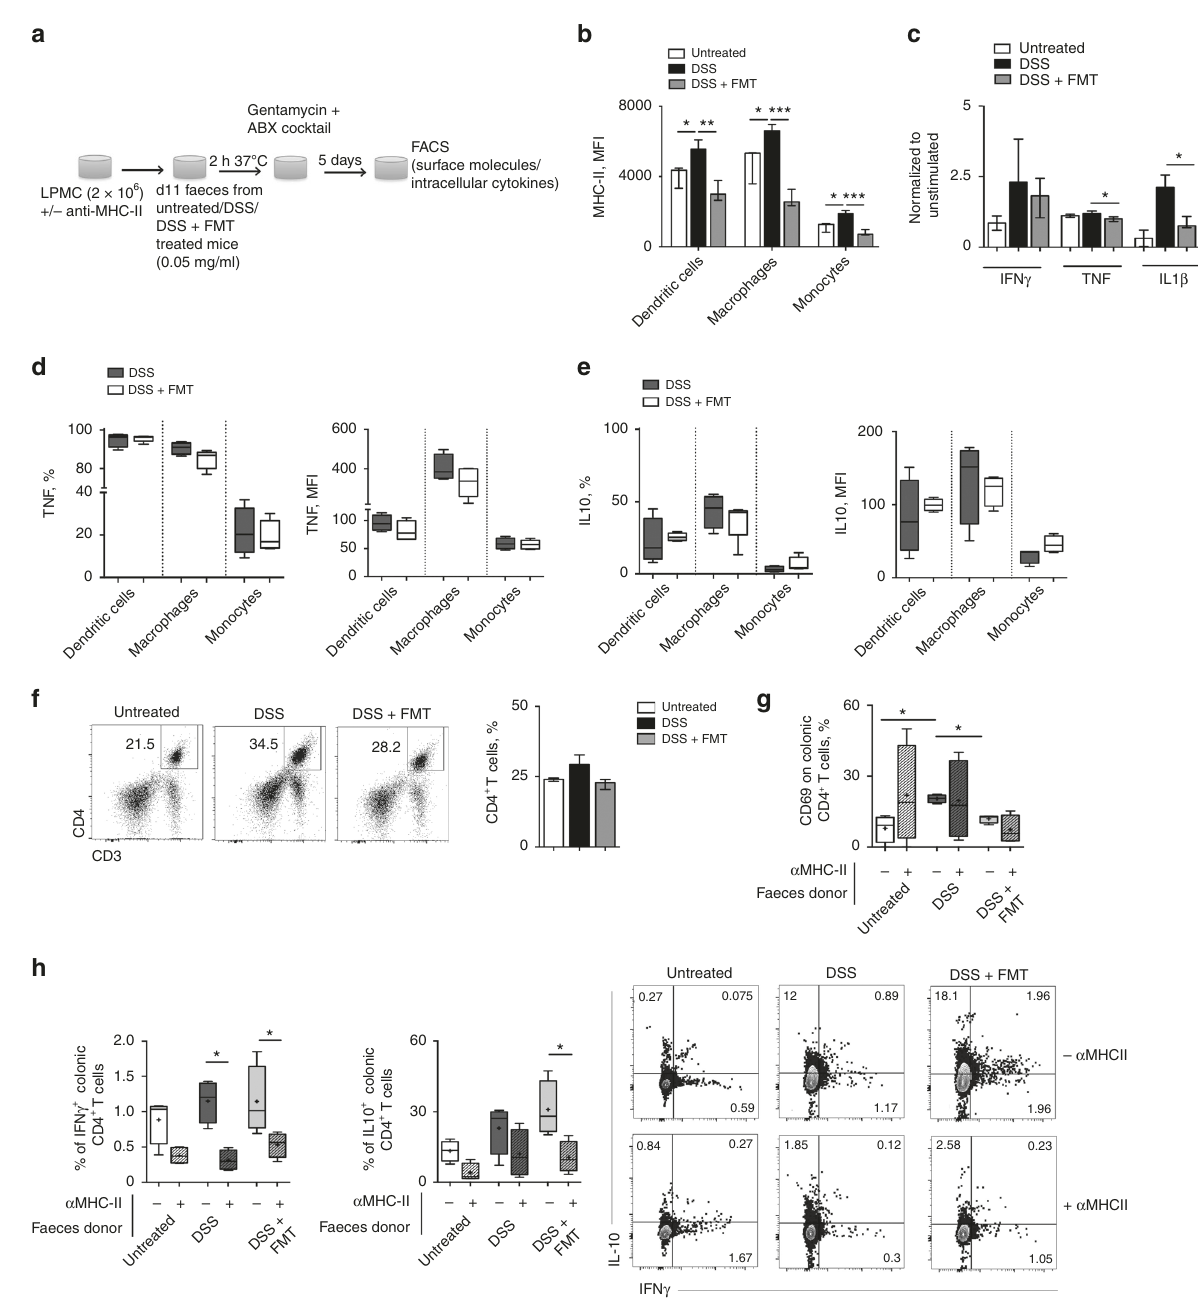
Fig. 6 Bacterial antigens presentation is required for CD4 + T cells cytokine skewing. a Schematic representation of the experiment. b Mean fl uorescence intensity (MFI) of MHC-II on dendritic cells, macrophages, monocytes, neutrophils exposed in vitro to faeces isolated from untreated (white bars), DSS (black bars) and DSS + FMT (grey bars) treated mice. c IFNg, TNF and IL1b cytokines levels in supernatants of LPMC in vitro exposed to faeces isolated from untreated (white bars), DSS (black bars) and DSS + FMT (grey bars) treated mice. Cytokines levels were normalised to unstimulated spontaneous secretion by LPMC. d , e Frequencies (left graphs) and MFI (right graphs) of TNF- ( d ) and IL-10- ( e ) secreting dendritic cells, macrophages and monocytes exposed in vitro to faeces isolated from DSS (dark gray bars) and DSS + FMT (white bars) treated mice ( f ) Representative dot plots and frequencies of CD4 + T cells exposed in vitro to faeces isolated from untreated (white bars), DSS (black bars) and DSS + FMT (grey bars) treated mice. g CD69 expression on intestinal CD4 + T cells exposed in vitro to faeces isolated from untreated (white boxes), DSS (black boxes) and DSS + FMT (grey boxes) treated mice in the presence (striped bars) or absence ( fi lled bars) of blocking α MHC-II antibodies. h Frequencies and representative dot plots of IFN γ and IL-10 secreting intestinal CD4 + T cells exposed in vitro to faeces isolated from untreated (white bars), DSS (black bars) and DSS + FMT (grey bars) treated mice in the presence (striped bars) or absence ( fi lled bars) of blocking α MHC-II antibodies. Statistical signi fi cance was calculated using a Mann – Whitney test for comparison within two groups or Kruskal – Wallis test with Dunn ’ s multiple comparison correction within more than two groups. * P < 0.05, ** P < 0.01, *** P < 0.001 were regarded as statistically signi fi cant. Outliers were detected with Grubb ’ s test. Non parametric distributions were represented as median + / − interquartile range. In Box and whiskers plots, centre line represents median; cross, represents mean; dots represent outliers. In all panels UT n = 5, DSS n = 7, DSS + FMT n =